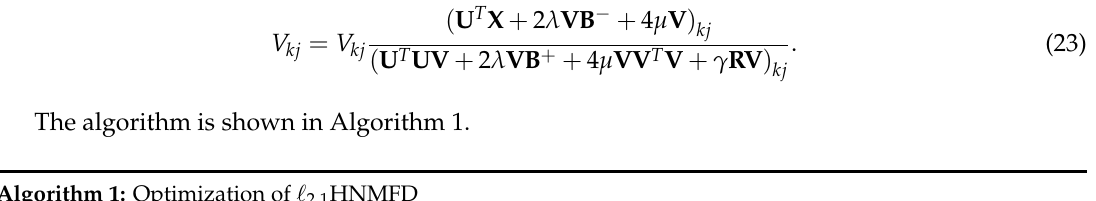
Algorithm 1: Optimization of (cid:96) 2,1